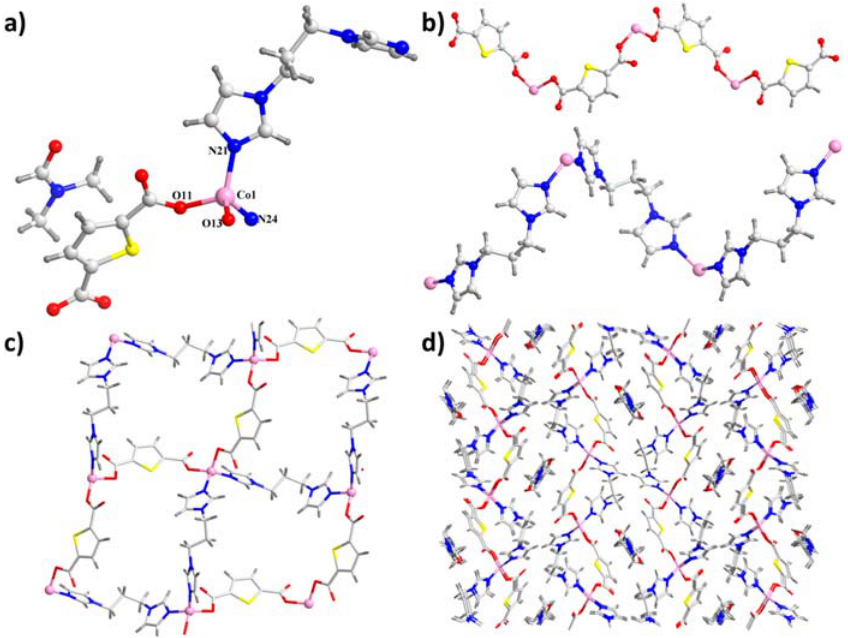
Figure 1: ( a ) View for the coordination surrounding of Co ( II ) ion in complex 1 . ( b ) The coordination patterns for the two ligands in 1 . ( c ) 1 ’ s two - dimensional layered network. ( d ) The packing diagram of 1 showing the voids that occupied via the DMF